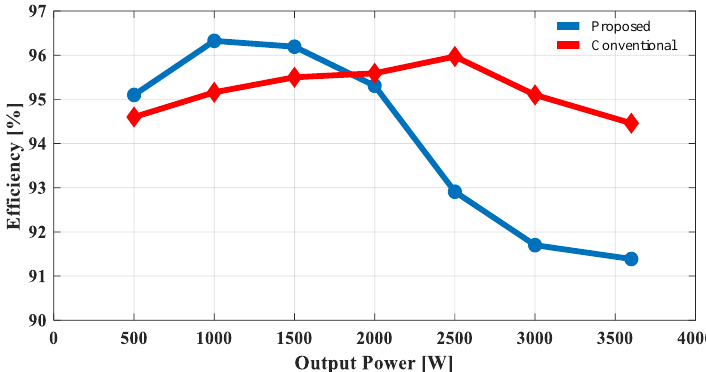
ffi ciency curve of the proposed buck Figure 14. Power conversion efficiency curve of the proposed buck rectifier. Figure 14. Power conversion e